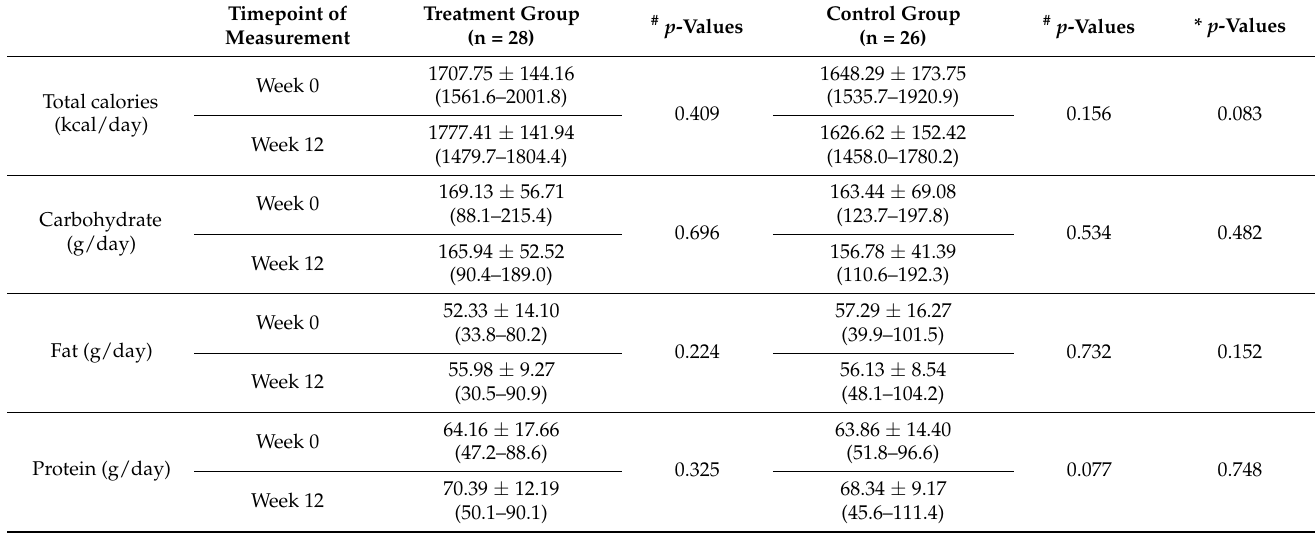
Table 1. The mean total calorie and macronutrient intake per day at Weeks 0 and 12 (n = 54). Timepoint of